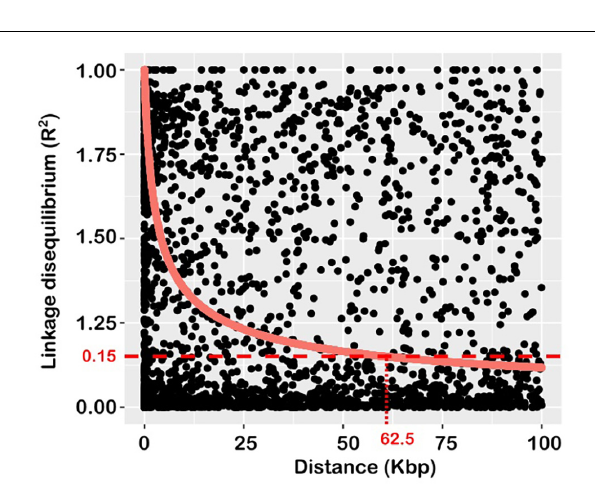
FIGURE 2 | Plot of average linkage disequilibrium (LD) values (r2) against inter-marker distances over a short (100 kbp) distance to visualise LD decay. The decay curve is the square root transformation of predicted LD values according to Andreescu et al. (2007). The horizontal and vertical dotted lines indicate the baseline r2 threshold value, and the extent of LD decay, respectively.